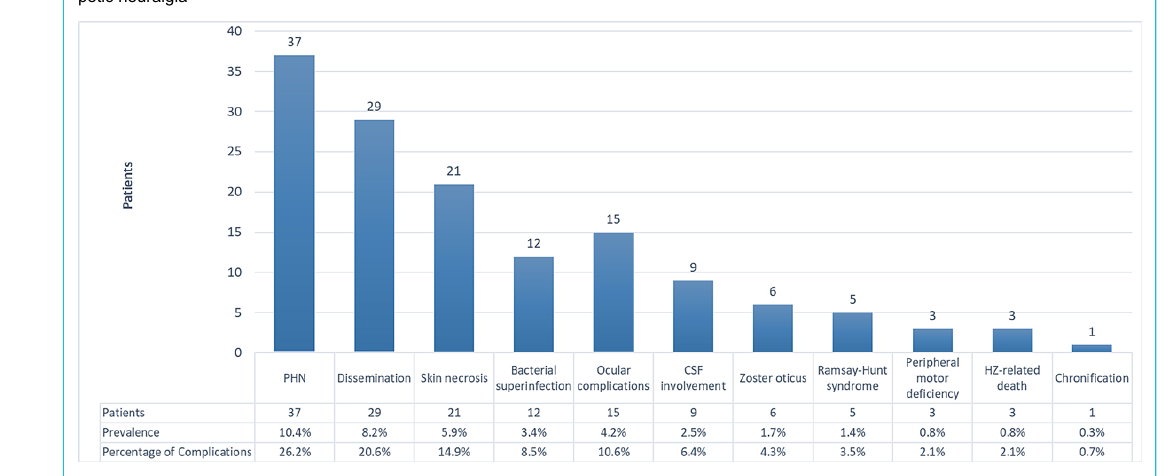
Figure 2: Types and prevalence of complications (percentage per 355 patients). CSF: cerebrospinal fluid; HZ: herpes zoster; PHN: post-her- petic